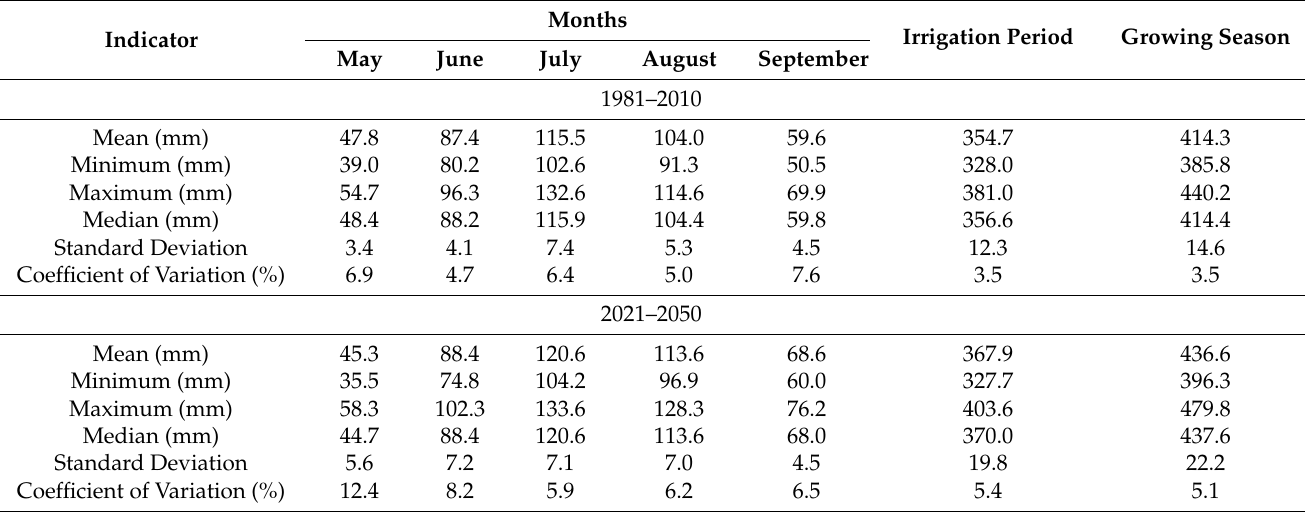
Table 2. Statistical indicators of grapevine evapotranspiration in individual months of the